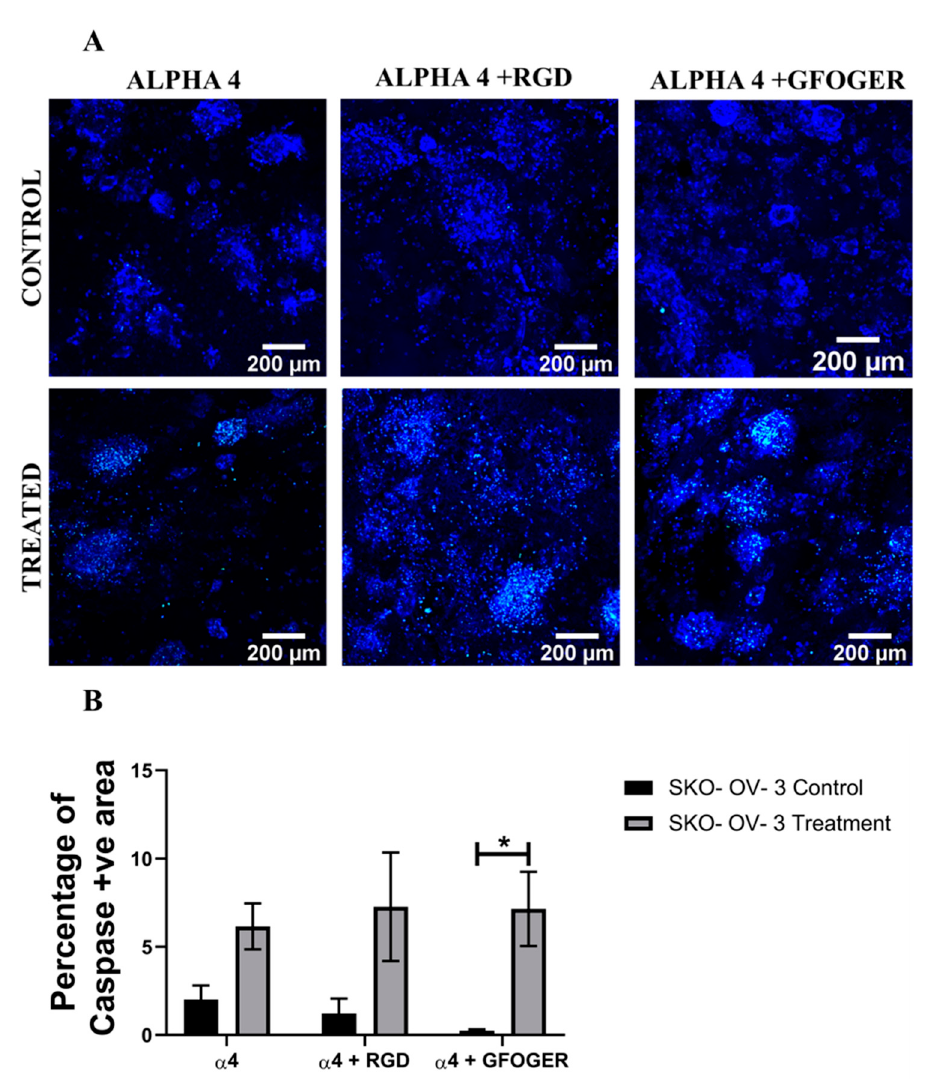
Figure 6. Effect of the chemotherapeutic Cisplatin on the apoptosis of SK-OV-3 EOC cells grown in different PeptiGels, 24 h post-treatment ( A ): Representative images for caspase 3/7 (apoptosis)–DAPI (green–blue) staining for both treated and untreated (control) SK-OV-3 PeptiGels. ( B ) Image analysis-based quantification of apoptotic (green) image areas for SK-OV-3 cells grown in the PeptiGels. Scale bar = 200 μ m. Quantitative data represent mean ± SEM for multiple images ( ≥ 3) and multiple hydrogels ( ≥ 3). * p ≤ 0.05.